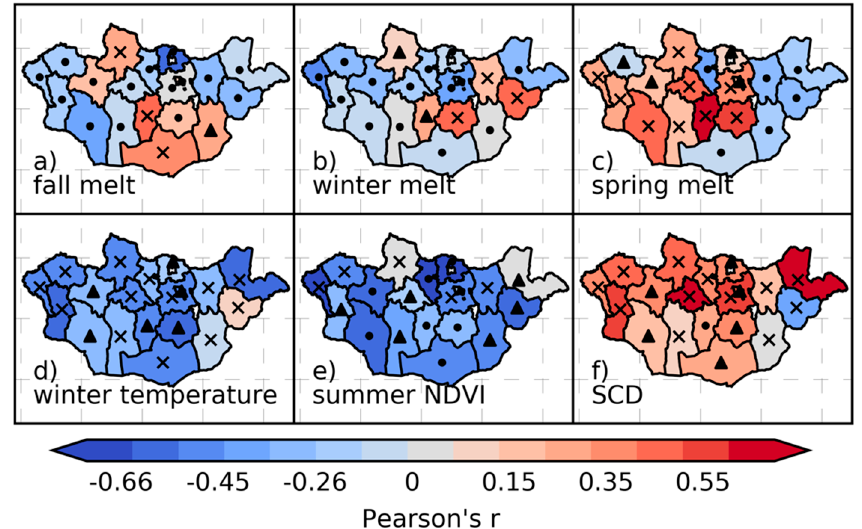
Figure 9. Correlations between dzud climate proxies and MI for WY 2003–2016. The black dots indicate weak correlations ( p > 0.1), black triangles indicate moderate correlations (0.05 ≤ p < 0.1) and the black ‘x’ symbols indicate strong correlations ( p < 0.05).